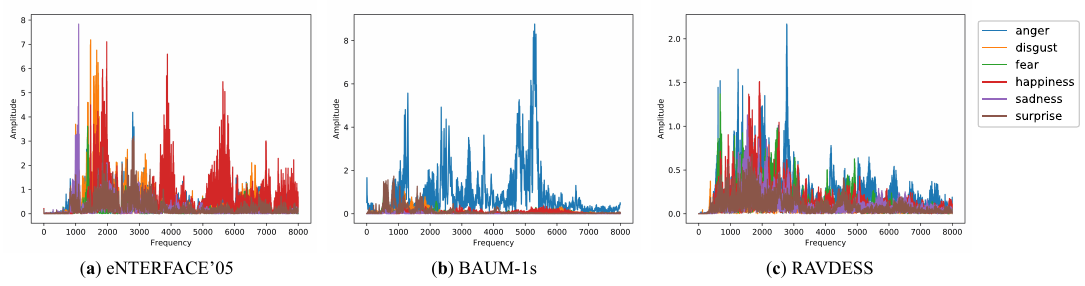
Figure 3. Statistical average results of the spectrograms of eNTERFACE’05, BAUM-1s, and RAVDESS